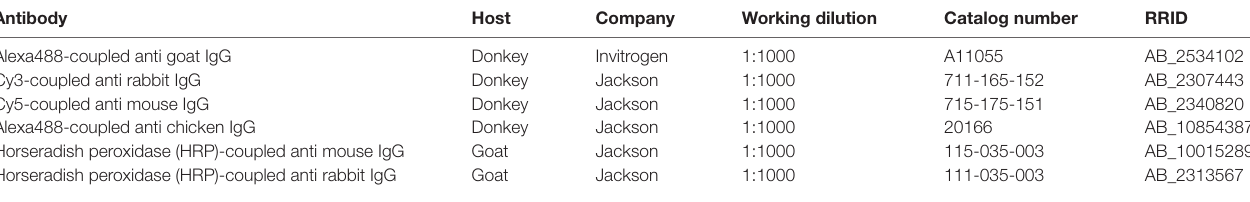
TABLE 2 | Secondary antibodies.